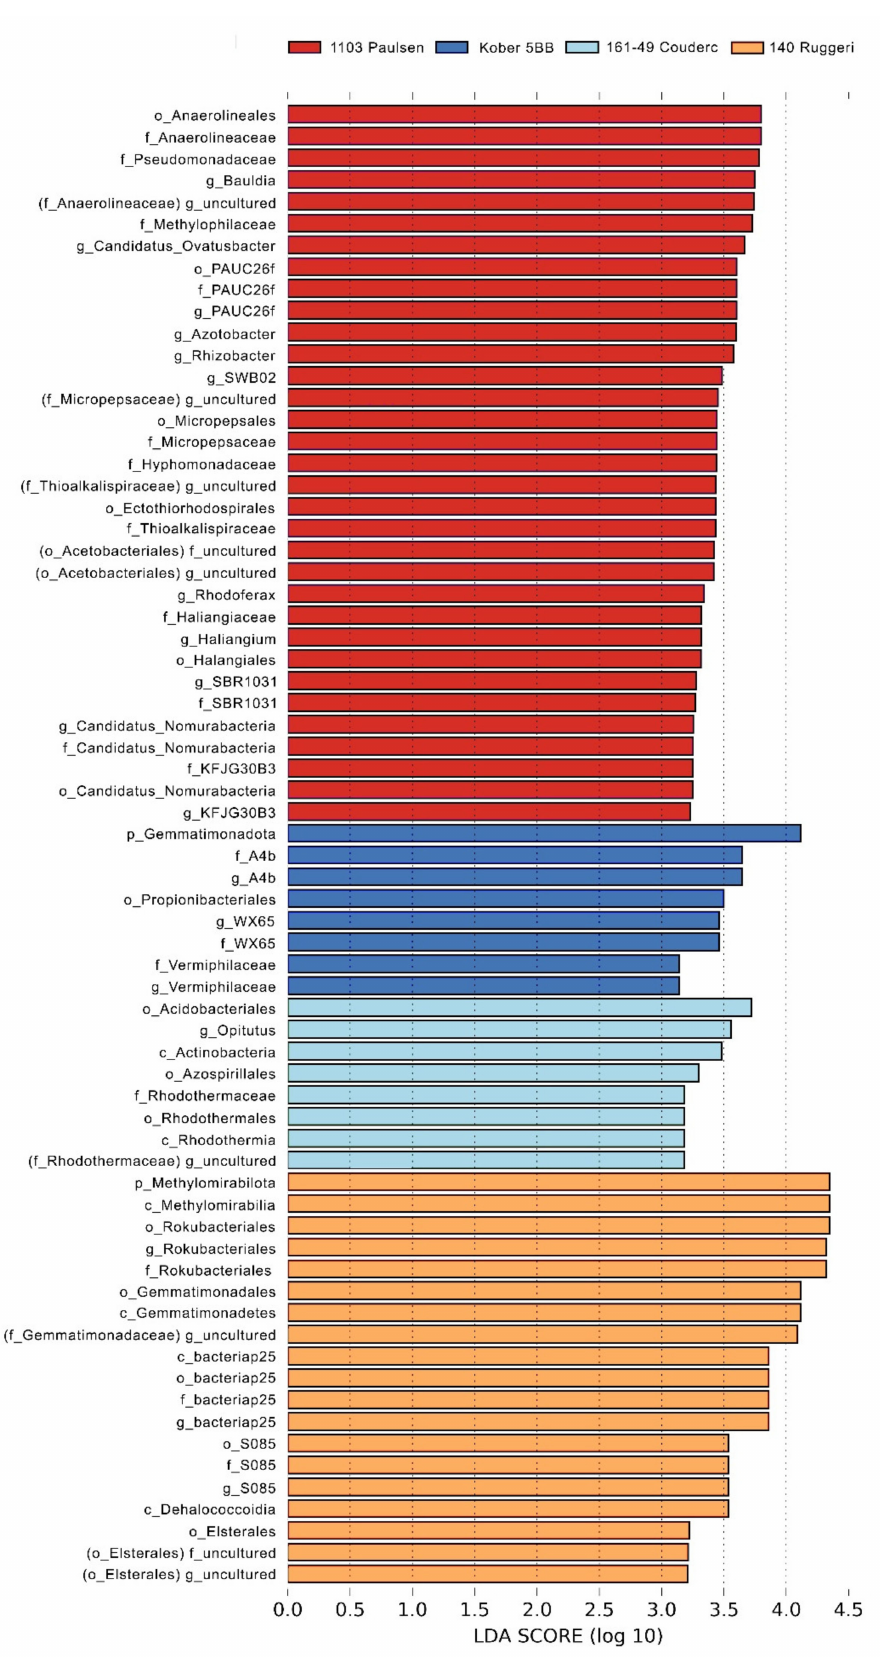
Figure 4. Histogram of the linear discriminant analysis (LDA) scores reveals the most differentially abundant taxa among the four rootstocks 1103 Paulsen, 140 Ruggeri, 161-49 Couderc and Kober